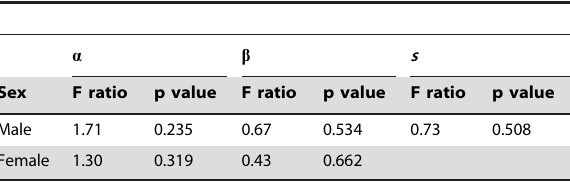
Table 3. Treatment effects on logistic (male) and Gompertz (female) mortality parameters when measured under severe desiccation stress at generation 15(10